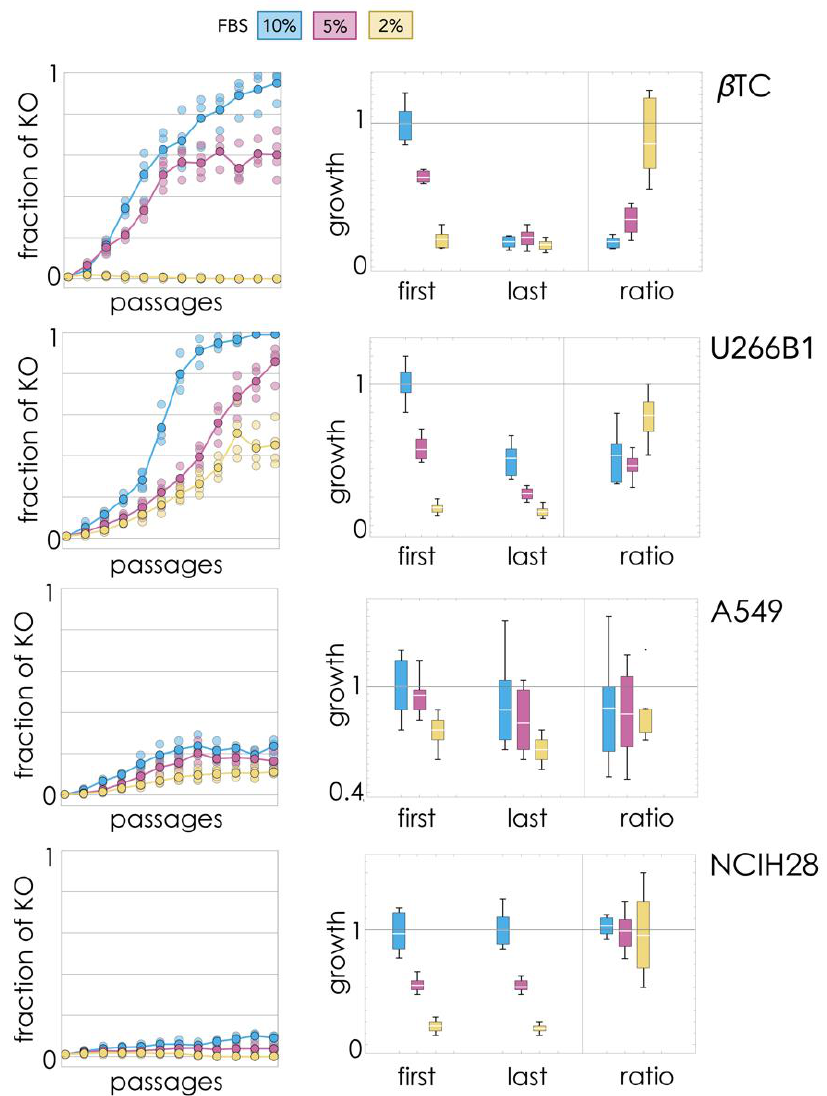
Figure 1. Change over time in the fraction of KO cells and relative growth of populations when 1% KO cells are introduced in a population of the WT cell line, with different amounts of FBS. The left panels show the fraction of KO cells in each population (light dots) and the mean value of four populations (darker dots connected by a line) at each passage. The right panels show the growth rates (relative to the average maximum growth rate) and their ratio for the first and last passage.